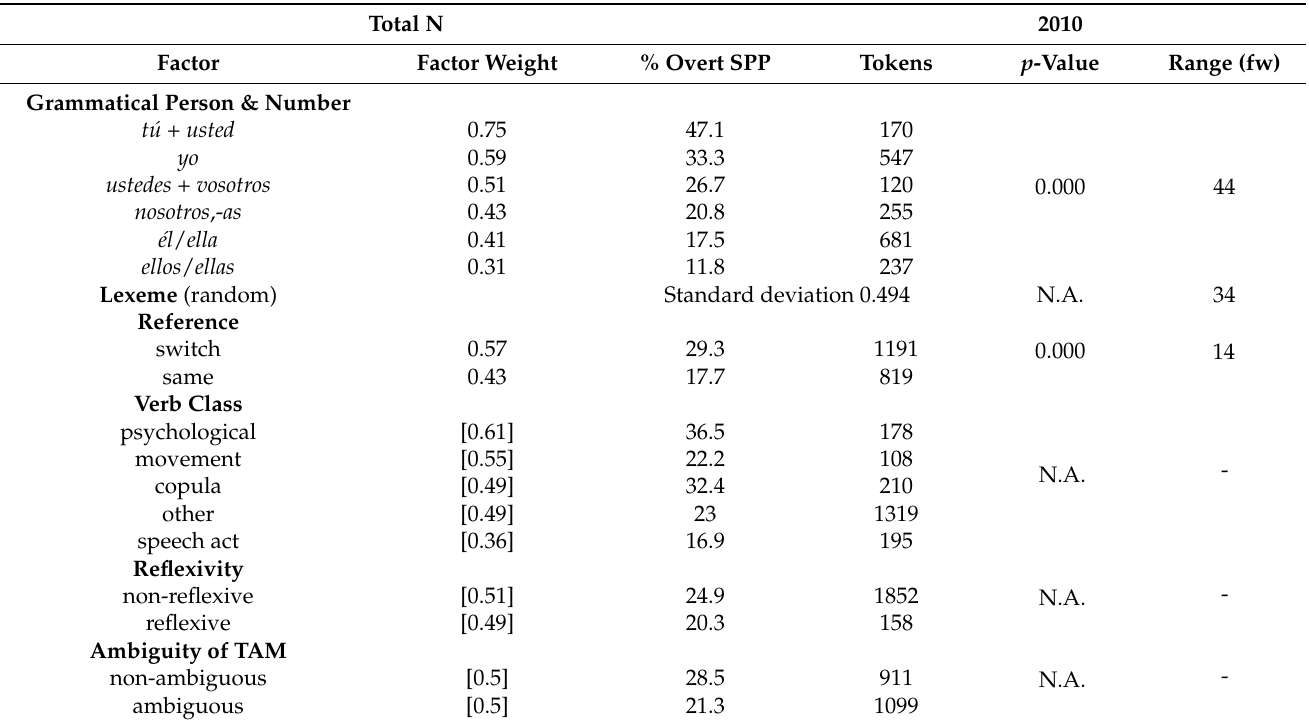
Table 4. Rbrul analysis of internal factors contributing to overt SPPs in Tucson 19th and 20th century